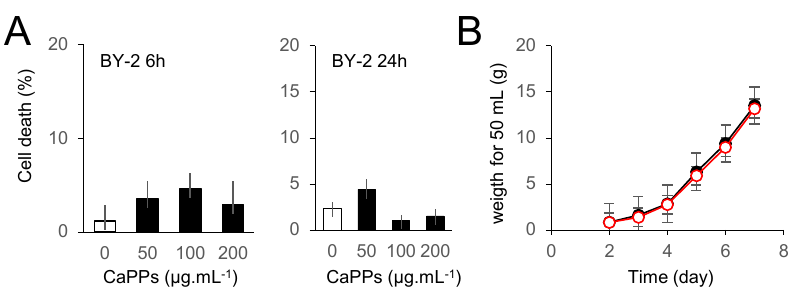
Figure 5. CaPPs cytotoxicity in BY-2 cultured cells. ( A ). Cell death extent in BY-2 cultured cells detected by the Evans Blue staining after 6 or 24h of treatment with various concentrations of CaPPs. ( B ). BY-2 cultured cell growth during 7 days in the presence or not of 200 µ g.mL − 1 CaPPs. The data corresponded to means of at least 4 independent replicates and error bars corresponded to